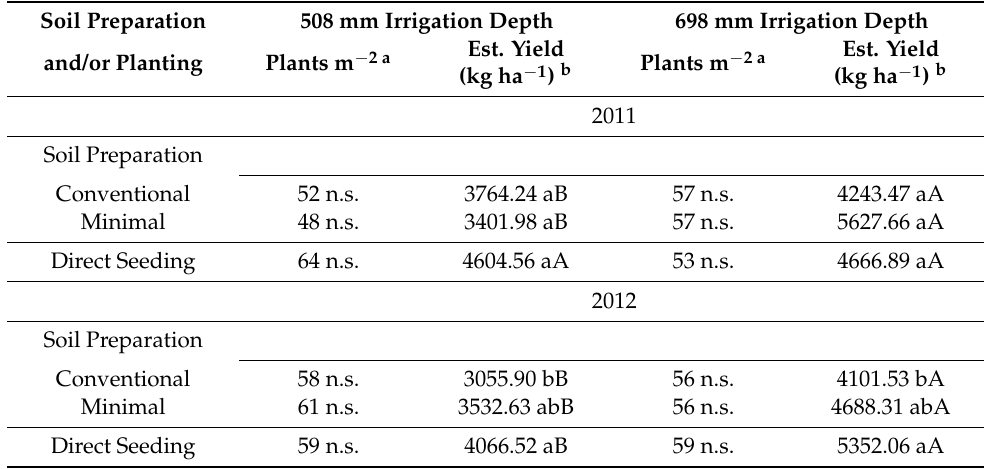
Table 4. Plant density and estimated irrigated wheat yield with different soil preparations in 2011 and 2012 in Tangar á da Serra, Mato Grosso state,